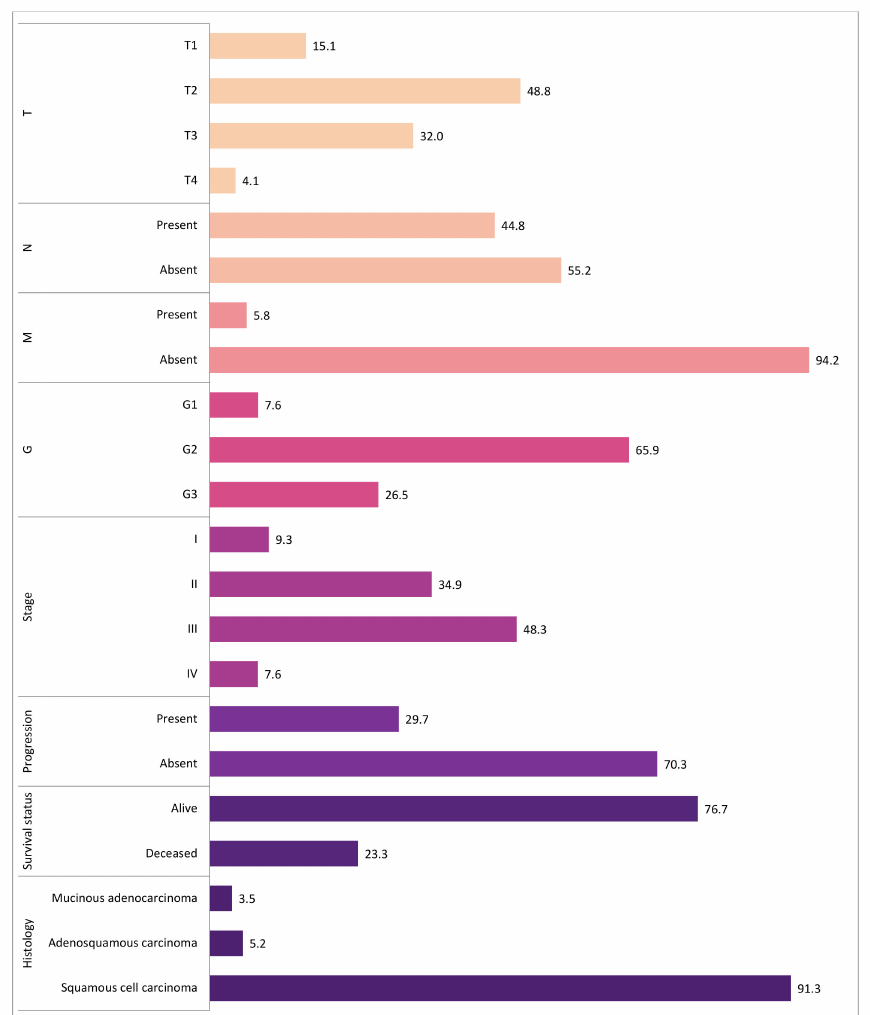
Figure 1. The distribution of tumor and disease characteristics. The bars represent the percentage distribution of tumor and clinical characteristics such as T, pathological tumor size; N, cancerous nearby lymph nodes; M, distant metastasis; G, tumor differentiation grade; stage; progression; survival status; histological tumor type. There were missing data ( n = 2) in the tumor differentiation grade (G) category. The different color indicates different